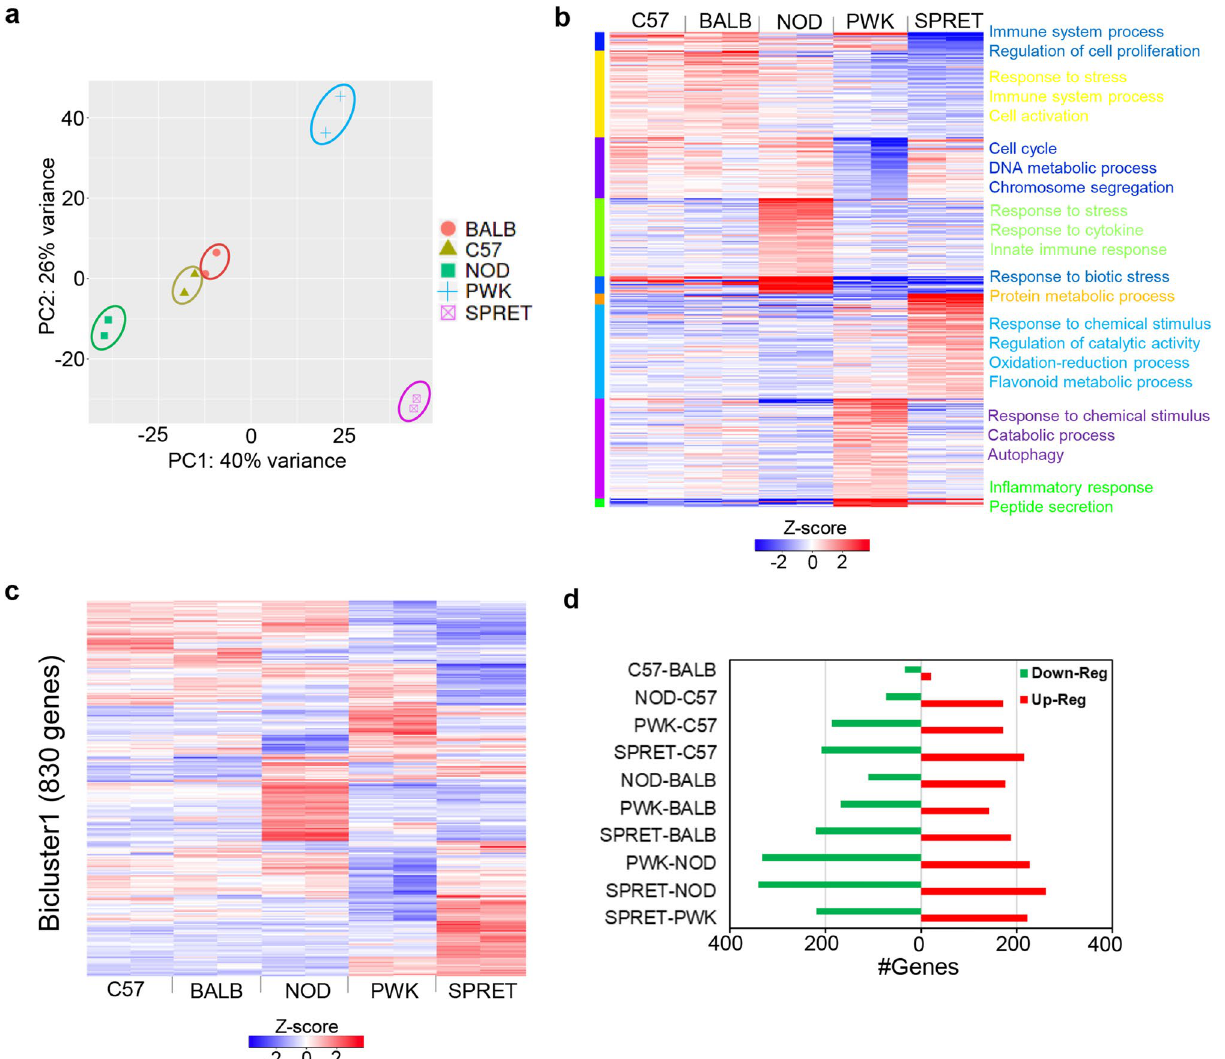
Figure 2. Unified and distinct gene expression patterns of unstimulated bone marrow-derived macrophage (BMDM) across diverse murine strains reveal significant diversified immune system response signal pathways to maintain basal hemostasis. ( a ) PCA visualization of the RNA-seq in five mice strains (C57, BALB, NOD, PWK, and SPRET) was labeled with distinct colors. The plot showing highly consistent RNA-seq clustered together for each mice strain. ( b ) Heatmap of 6000 most variable expressed genes out of 12,218 BMDM expressed genes in five mice strains based on k -means clustering along with significantly enriched biological processes. The clustered columns represent the expression in mice strains, whereas each row represents a gene (adjusted P -value < 0.05, expression colored based on TPM z-score). ( c ) CC Bicluster algorithm (BCCC) discovered 830 highly correlated genes in cluster1 and significantly enriched in immune systems biological process across five mice strains (colored based on TPM z-score). ( d ) The number of differential expressed genes (DEGs) maintaining basal homeostasis between different mouse strains ( FDR = 0.05, FC ≥ |2|). Red represents up-regulated and the green represents down-regulated genes from one to another strain. C57 and BALB have the least number of